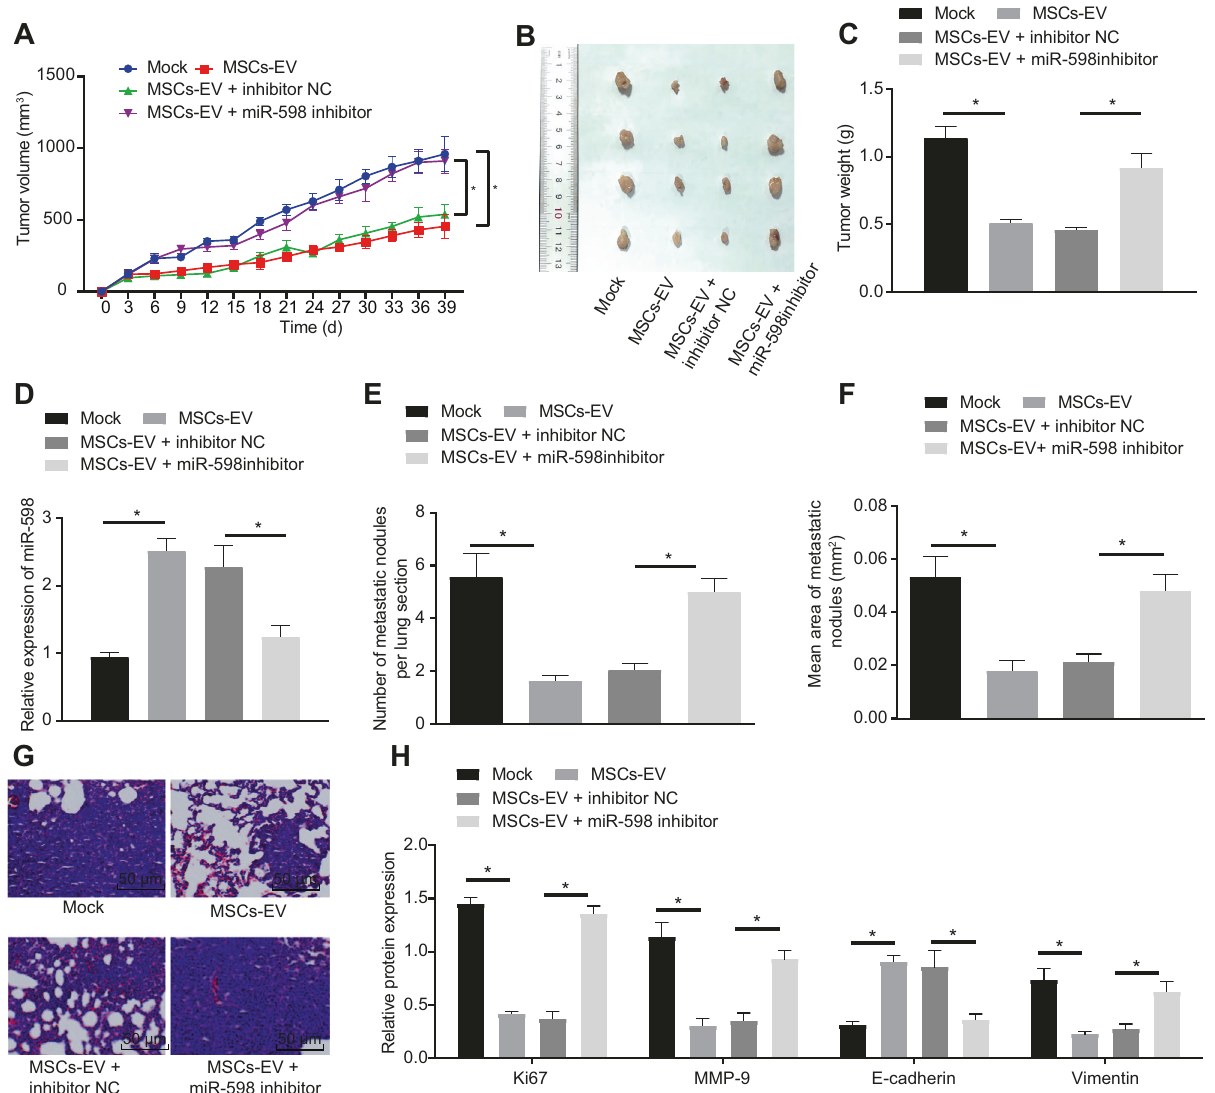
Fig. 4 Effects of EVs-derived miR-598 on tumor growth and metastasis of NSCLC in vivo. A Tumor volume in the nude mice after different treatments. B Representative white-light images of tumors after different treatment. C Tumor weight in the nude mice after different treatments. D Expression of miR-598 in tumors of the nude mice after different treatments by RT-qPCR. E Number of metastatic nodules in the lungs of nude mice with pulmonary metastasis. F Area of metastatic nodules in the lungs of nude mice. G Morphology of metastatic nodules in the lungs of nude mice e observed by H&E staining. H Protein levels of Ki67, E-cadherin, Vimentin, and MMP-9 in metastatic nodules in the lungs of nude mice by Western blot analysis. n = 6 in each group in the subcutaneous tumorigenesis experiments, n = 15 in each group in the pulmonary metastasis experiments. * p < 0.05 between two groups. Data among multiple groups were compared by ANOVA with Tukey ’ s post hoc test. Comparisons among groups at different time points were performed using repeated measures ANOVA with Bonferroni ’ s post hoc